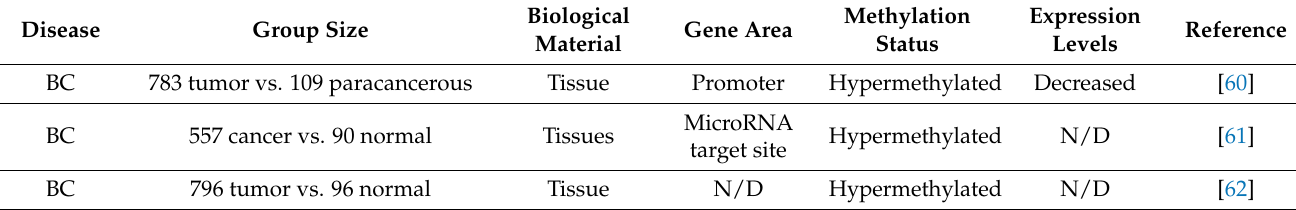
Table 1. Methylation status of ENPP2 in cancer in relation to